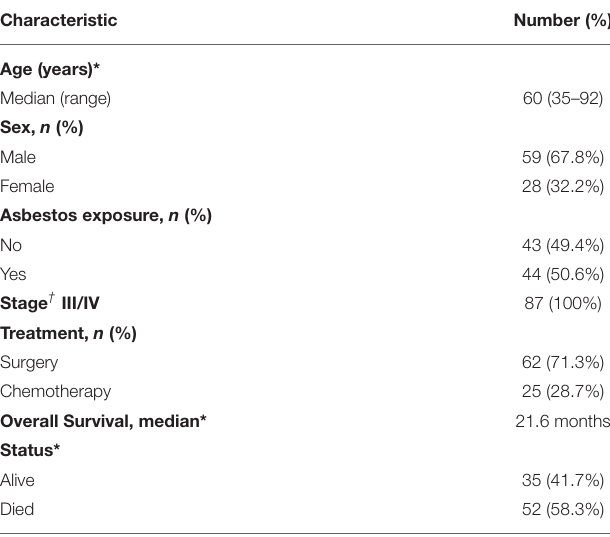
TABLE 1 | Clinical characteristics of patients with malignant mesothelioma.